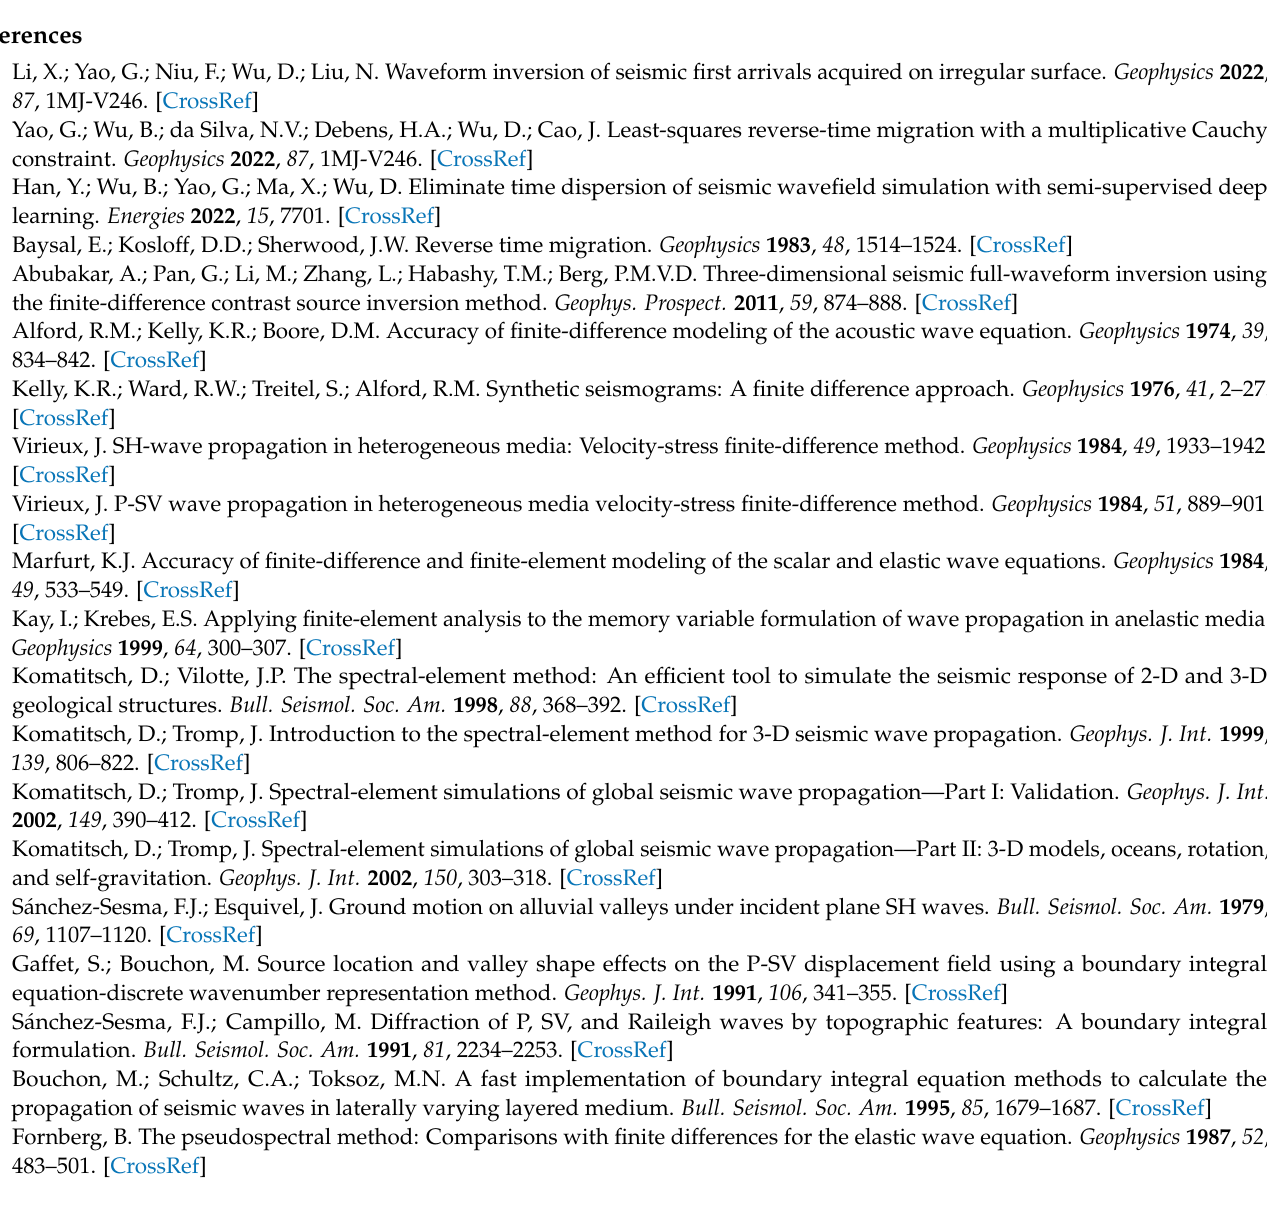
Table A1 shows all tridiagonal optimization schemes with different orders. OCFD6_2